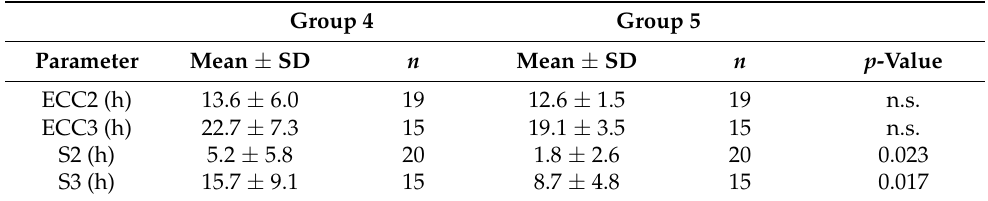
Table 3. Morphokinetic times in oocytes categorized into groups 4 (good quality) and 5 (best